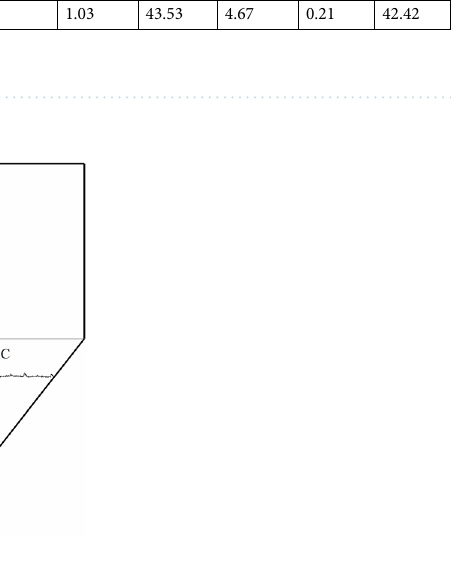
Figure 3. XRD spectra of OS-CS AC (before and after removal of Cr